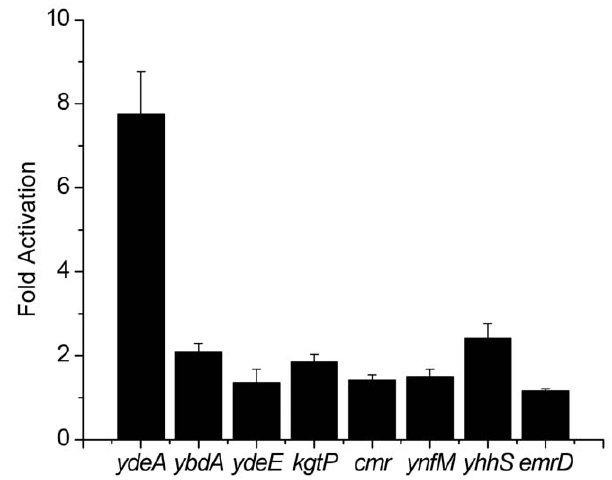
Figure 4. Efflux promoter transcriptional fusions. Reporters are in a wild-type background and the data are normalized to the relative fluorescence values when no arabinose is added. All of the strains were induced with 10 mM arabinose.